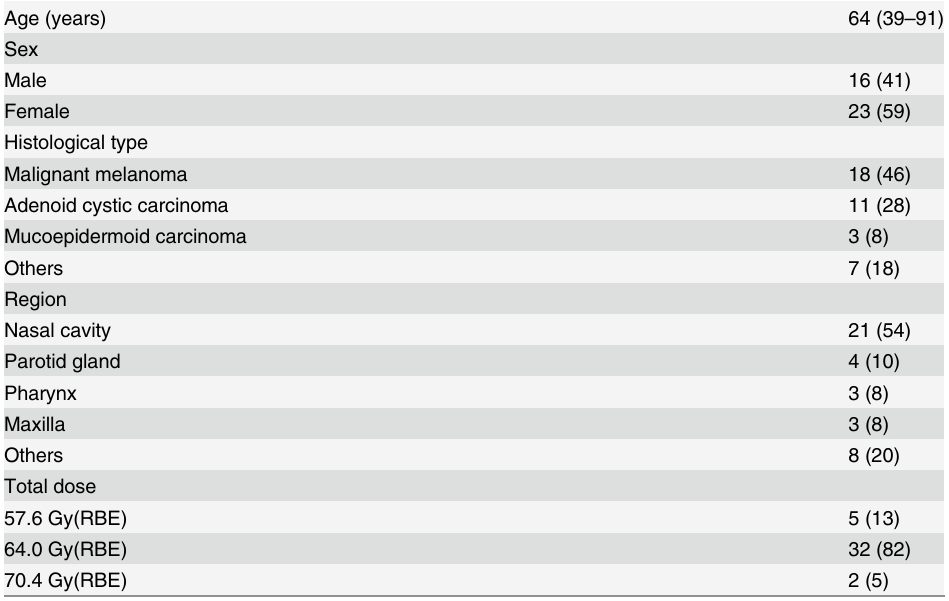
Table 1. Patient (n = 39) and tumor characteristics, in patients with head and neck tumors treated via carbon ion